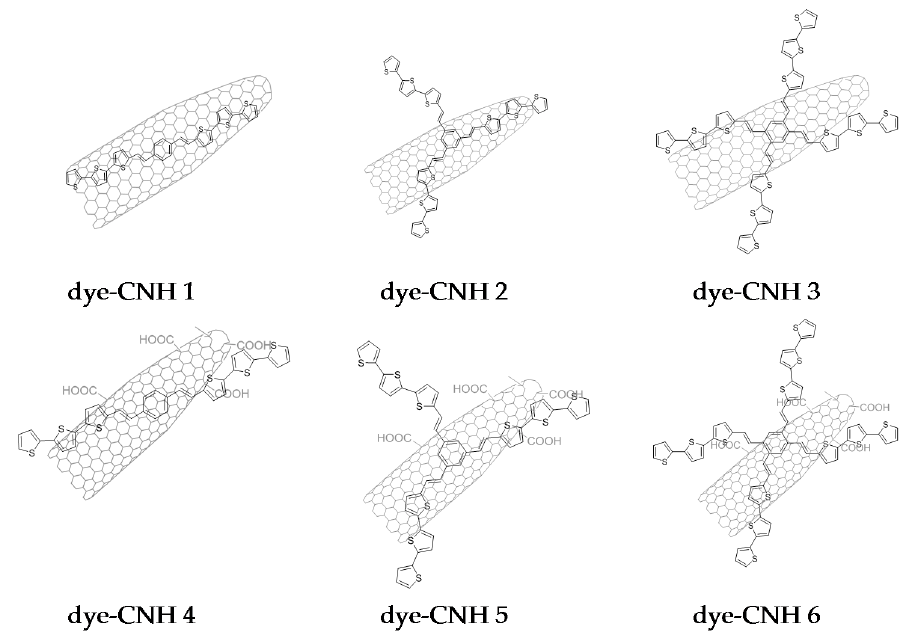
Figure 7. Codes and components of the functionalized CNHs used in the present work.